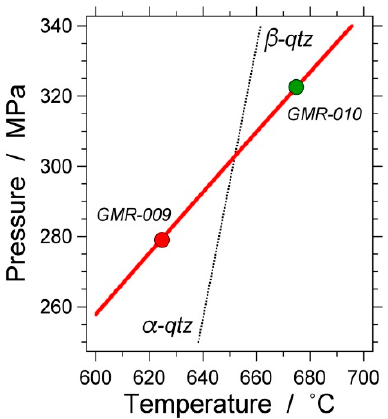
Figure 13. Temperature-pressure diagram with the experimental conditions of GMR-009 in the α -quartz stability field and GMR-010 in the β -quartz stability field. The red line is the isochore of 27.5 cm 3 /mol.